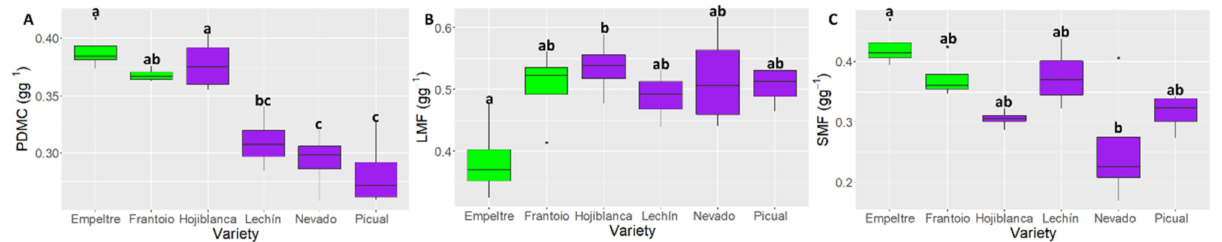
Figure 4. Boxplots showing median values of the ANOVA analysis of the most statistically significant plant traits: PDMC (‘Plant dry matter content’) ( A ), LMF (‘Leaf mass fraction’) ( B ) SMF (‘Stem mass fraction’) ( C ). Tolerant cultivars are represented in green color while the susceptible ones are shown in purple color. Letters indicate Tukey HSD post hoc tests at the p < 0.05 level, following